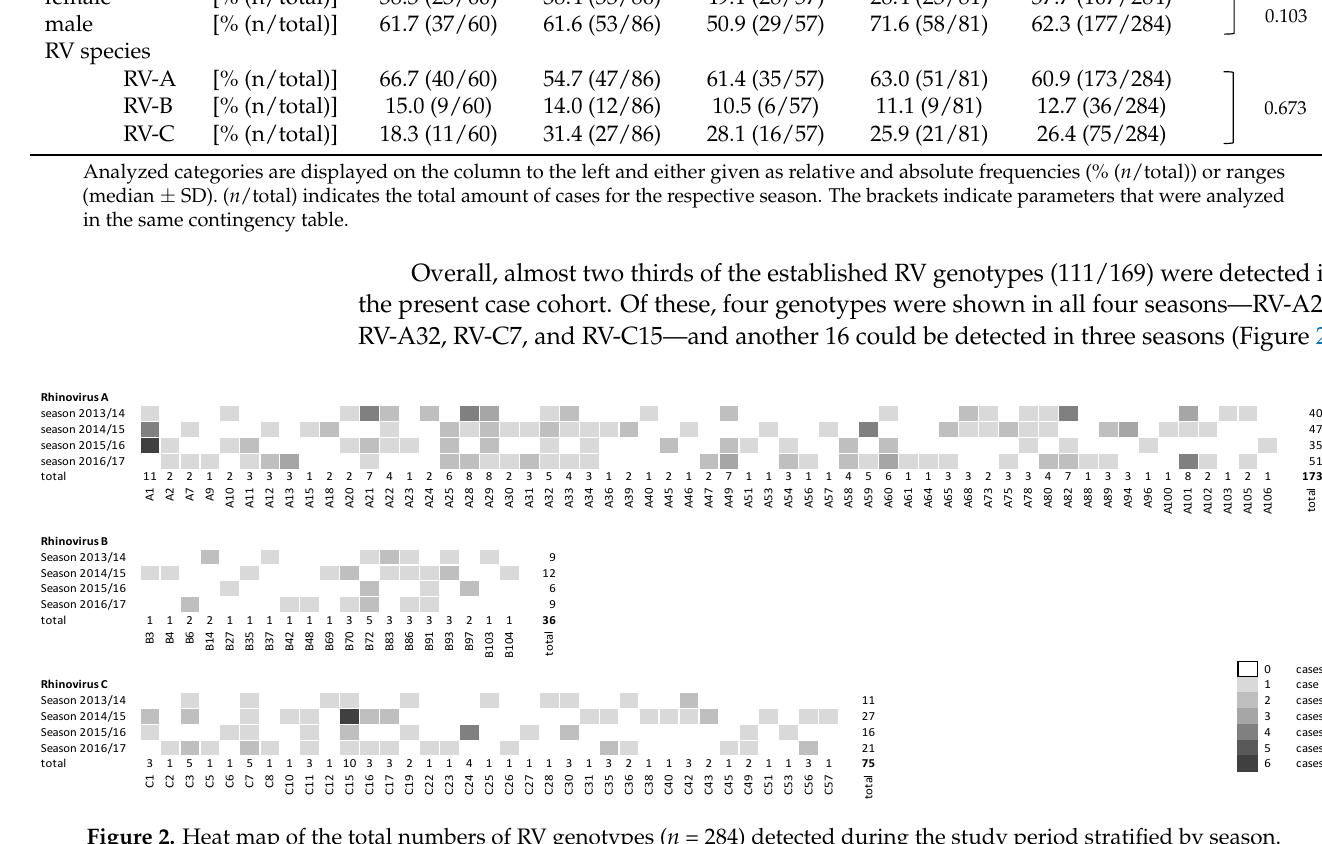
The mean age of the study population was 54.8 years, which did not differ signifi ‐ cantly between RV species ( p = 0.193) or between seasons ( p = 0.957). The gender was fe ‐ male for 37.7% and male for 62.3% of all patients. Again, no difference was noted between seasons ( p = 0.103) or between RV species ( p = 0.548) (Table 2). Figure 2. Heat map of the total numbers of RV genotypes ( n = 284) detected during the study period stratified by season. Regarding the whole study period, the most frequent genotypes of each species were: RV-A1 (3.9%, n = 11/284), RV-C15 (3.5%, n = 10/284), and RV-B72 (1.8%, n = 5/284). No seasonal pattern was shown for the occurrence of specific genotypes either within or between the studied seasons. In the subset of viruses with both VP1 and VP4/VP2 genes ( n = 270), the genotyping results of the two genetic regions matched in all cases. For